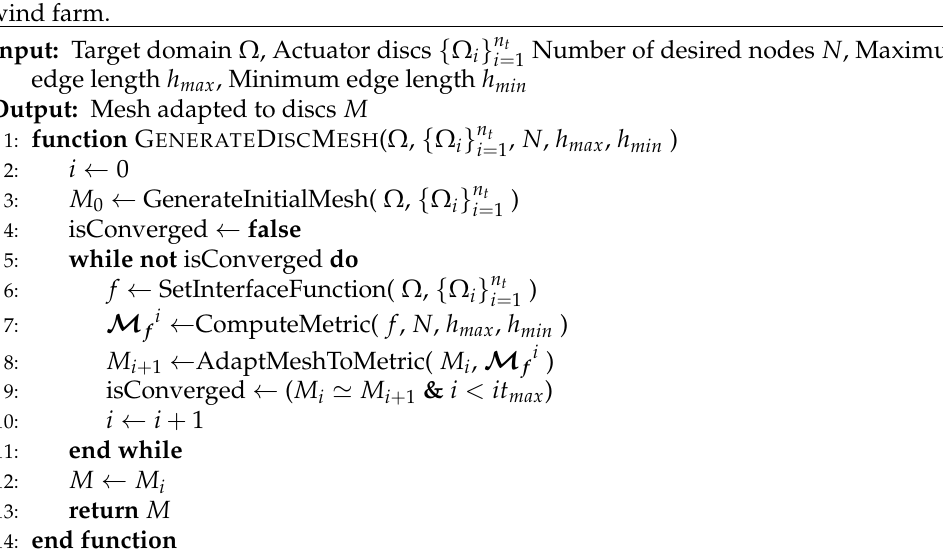
Algorithm 1 Generation of the a mesh adapted to the actuator disc representation of a wind farm.